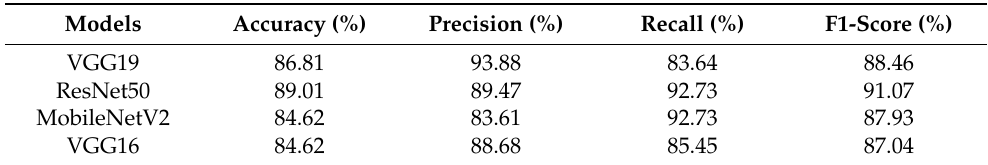
Table 9. Models with transfer learning from ImageNet for disc state classification with ROI and fine-tuning.